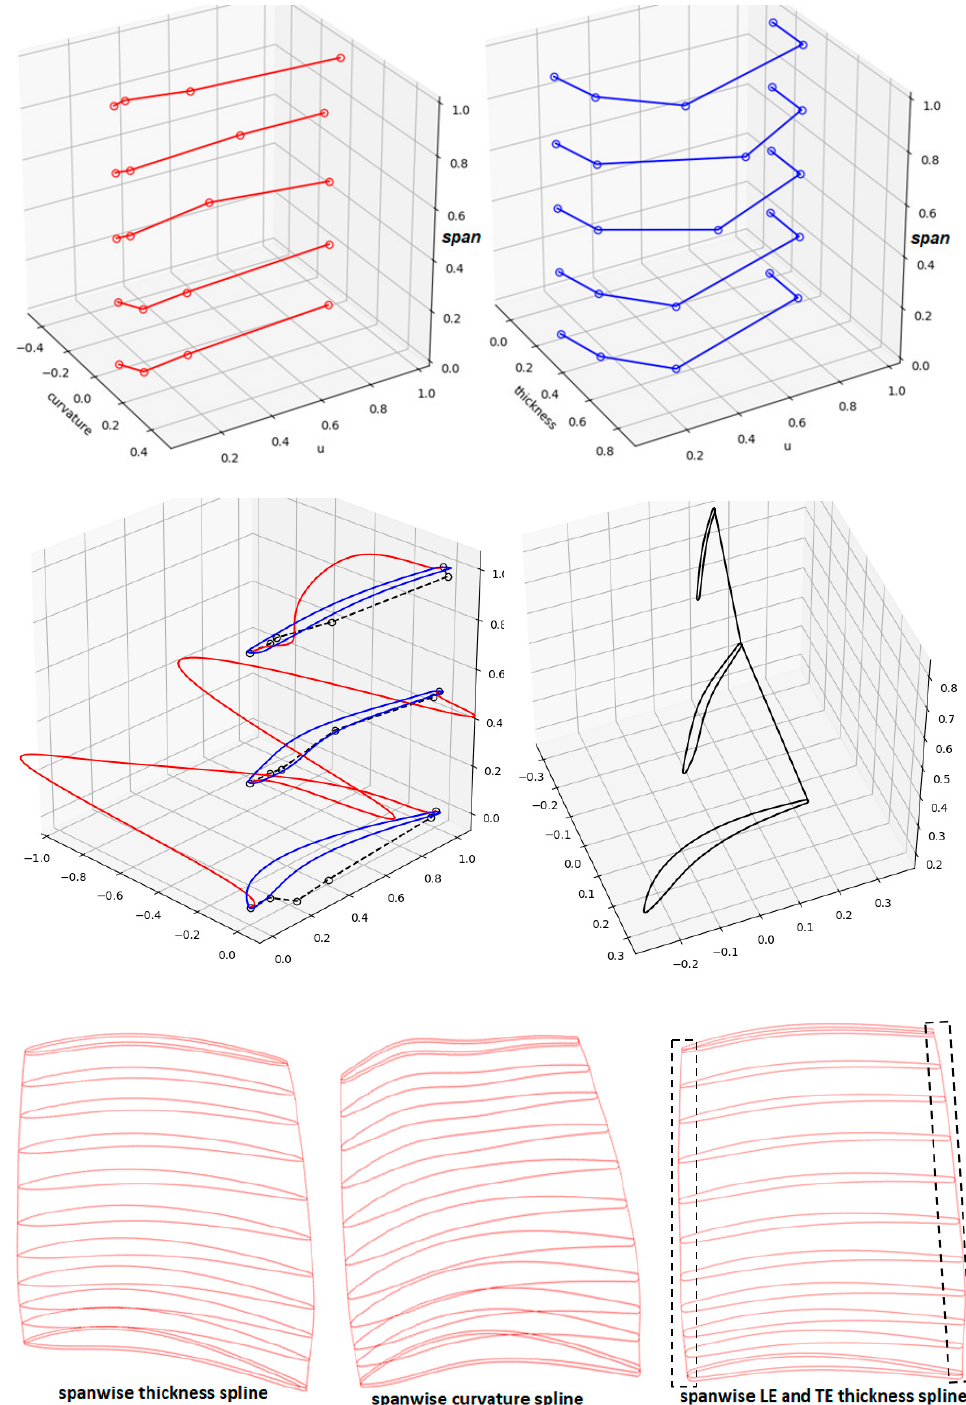
Figure 9. Spanwise and normalized unstaggered chordwise (u) B-spline control points of curvature (left) and thickness definition. 2D staggered airfoils constructed with the right chord definition are also shown. The last row shows spanwise spline for curvature, blade, and LE and TE thickness.